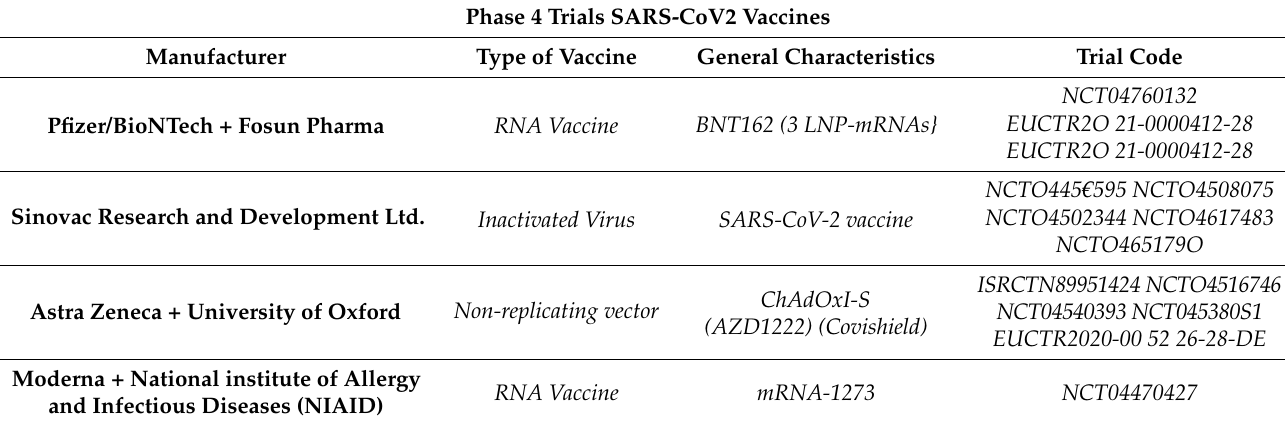
Table 2. SARS-CoV2 vaccines phase 4 trials, for each experimentation